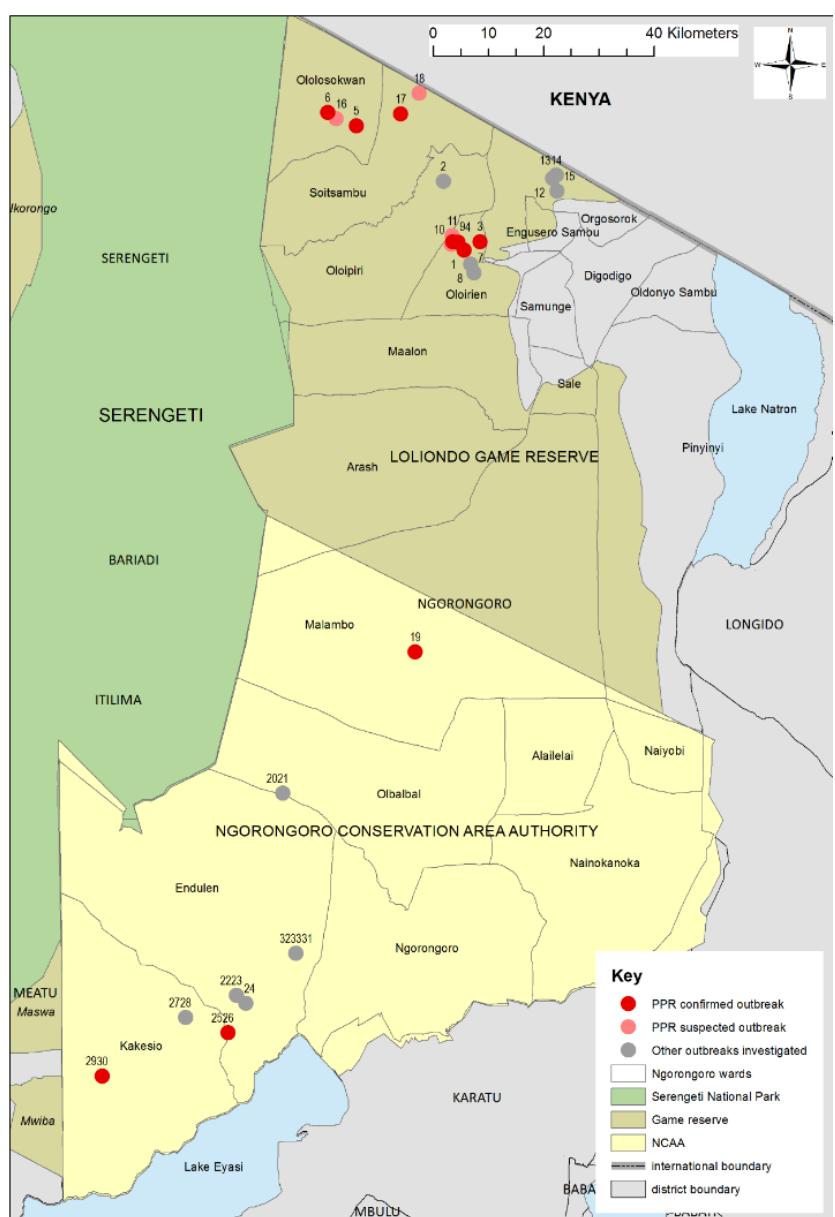
Figure 2. Map of Ngorongoro District showing the location of the flocks where outbreak investigations were carried out. Outbreak locations are represented by coloured circles and the flock number; red = PPRV disease confirmed; pink = PPRV disease suspected due to proximity to confirmed outbreak and similar clinical signs; grey = other outbreaks investigated but not confirmed as PPR. NCAA = Ngorongoro Conservation Area Authority.